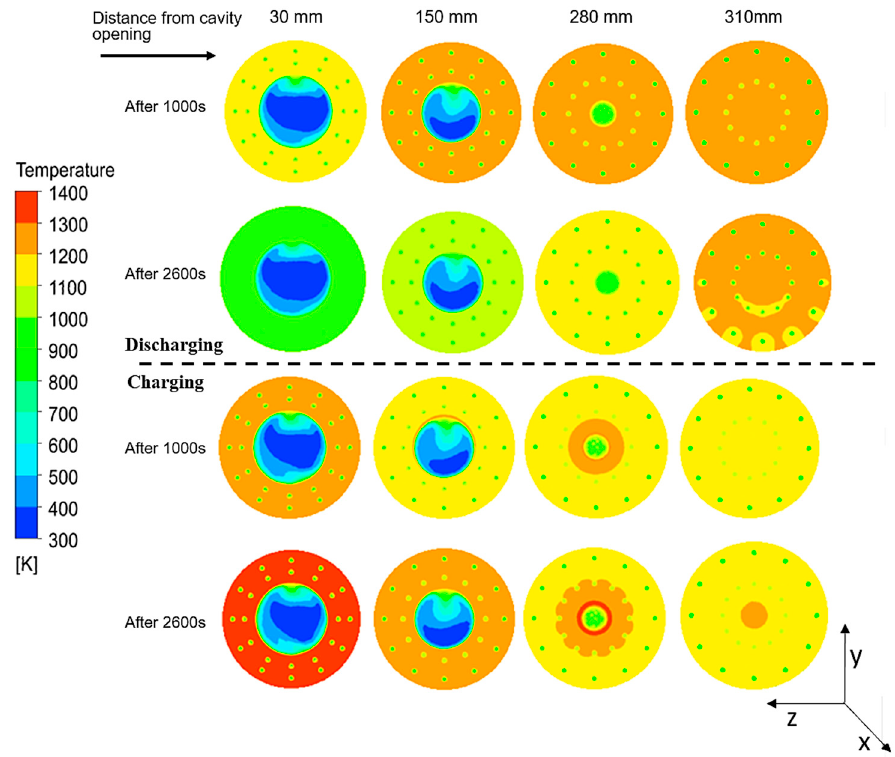
Figure 10. Temperature contours of several sections taken along the solar receiver axis during charging and discharging phases. Distance are taken from the cavity opening.